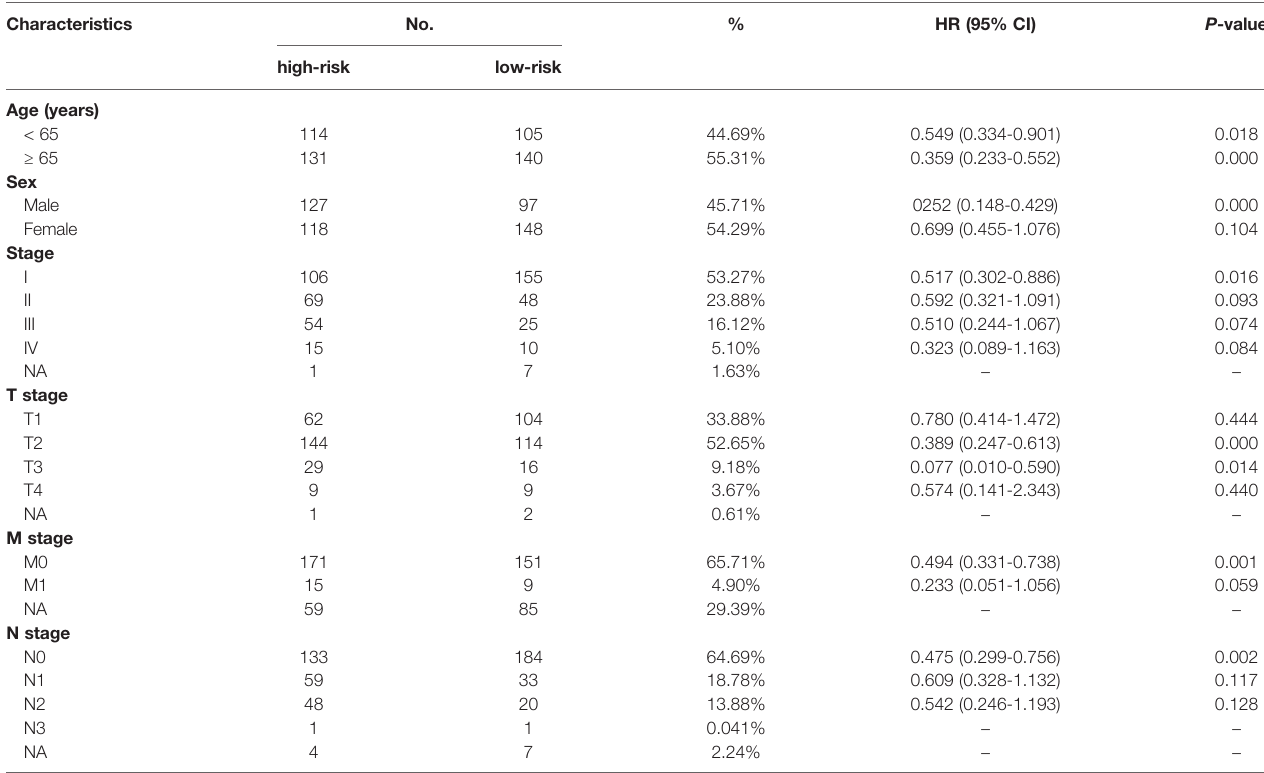
TABLE 1 | Prognostic roles of the MRGs signature with different demographic and clinical characteristics in TCGA training set. .